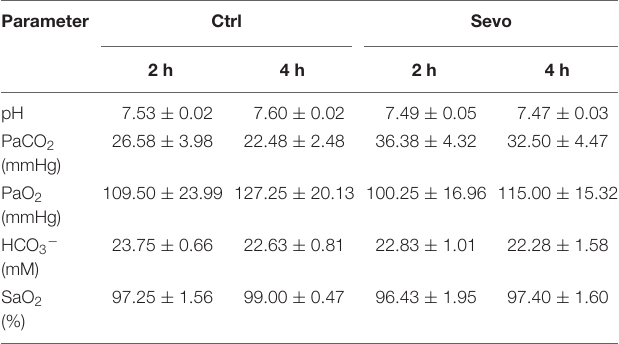
TABLE 1 | Arterial blood-gas analysis of postnatal-day-5 (P5) mice following 1.5% sevoflurane. Parameter Ctrl